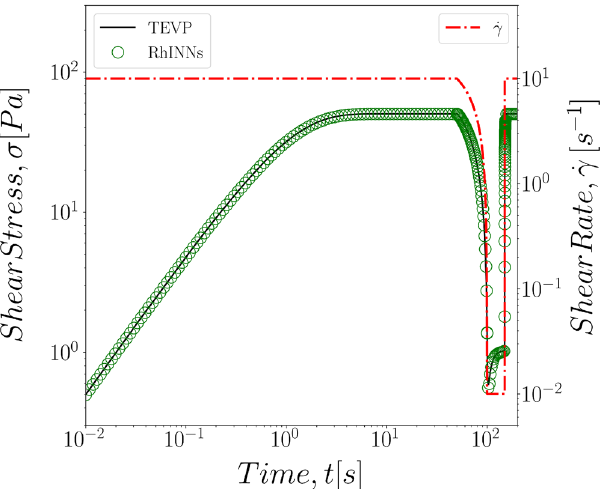
Figure 6. Direct RhINNs solution of a TEVP fluid’s stress response to a multi shear rate protocol. The model parameters are similar to ones in Fig. 5.